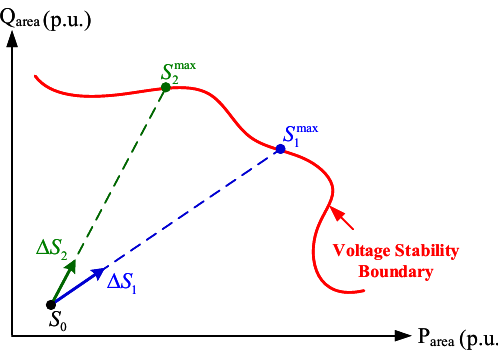
Figure 5. Load power parameter space.